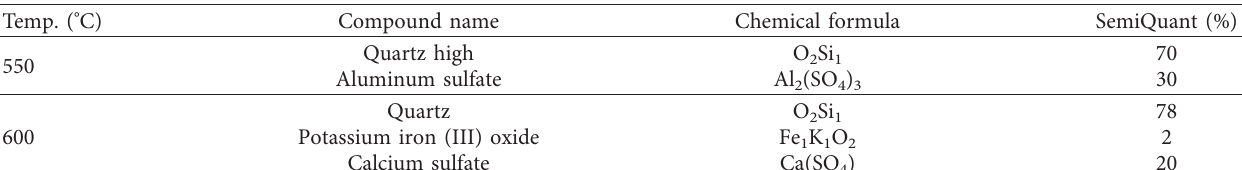
Table 12: XRD analysis of BD-4A